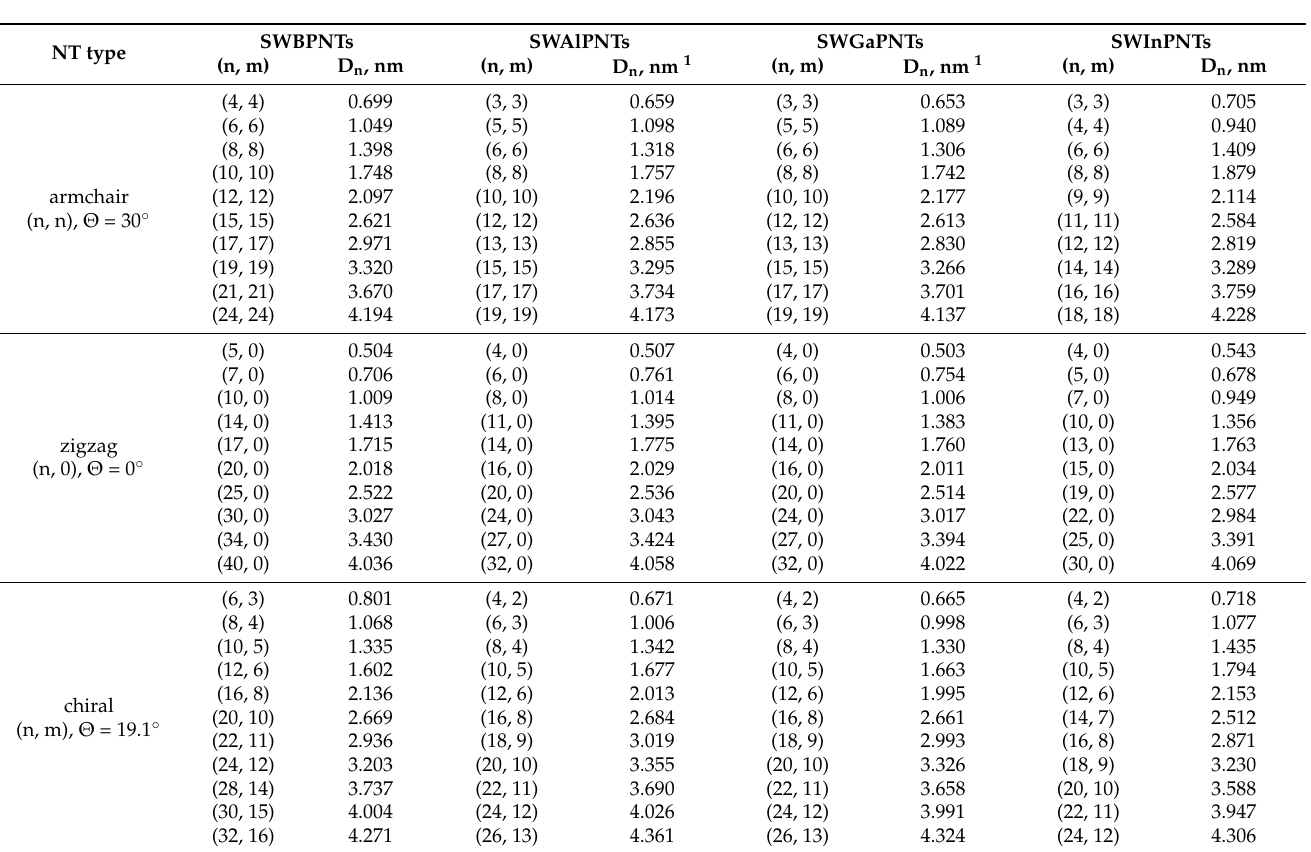
Table 5. Chiral indices and diameters of the SWBPNTs, SWAlPNTs, SWGaPNTs and